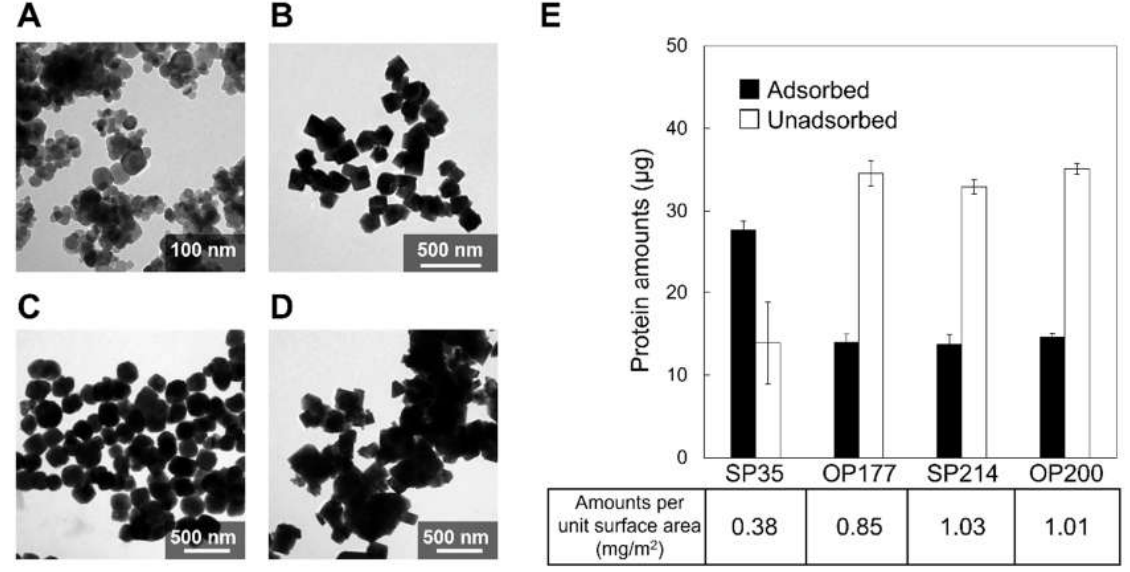
Figure 5. The TEM images of ( A ) SP35, ( B ) OP177, ( C ) SP214, and ( D ) OP200. ( E ) Adsorbed (black bar) or unadsorbed (white bar) protein amounts of His-Mms6 to different magnetite nanoparticles (SP35, OP177, SP214, and OO200). A solution containing 40 µg of protein was added to 2.5 mg of the particles.